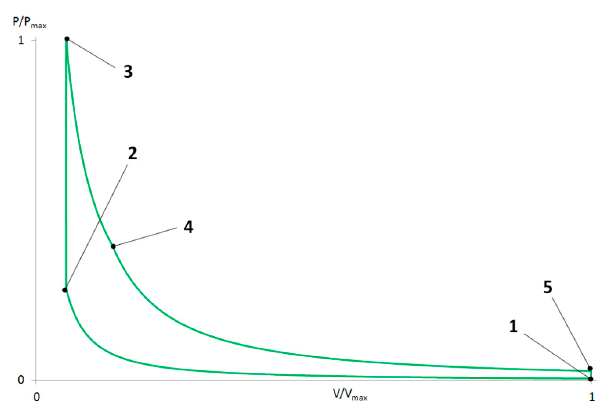
Figure 3. Proposed theoretical cycle with characteristic points, where: 1-2 suction; 2-3 isochoric transformation points; 3–4 the isothermal transformation points; 4-5 depressurization; 5-1 exhaust.